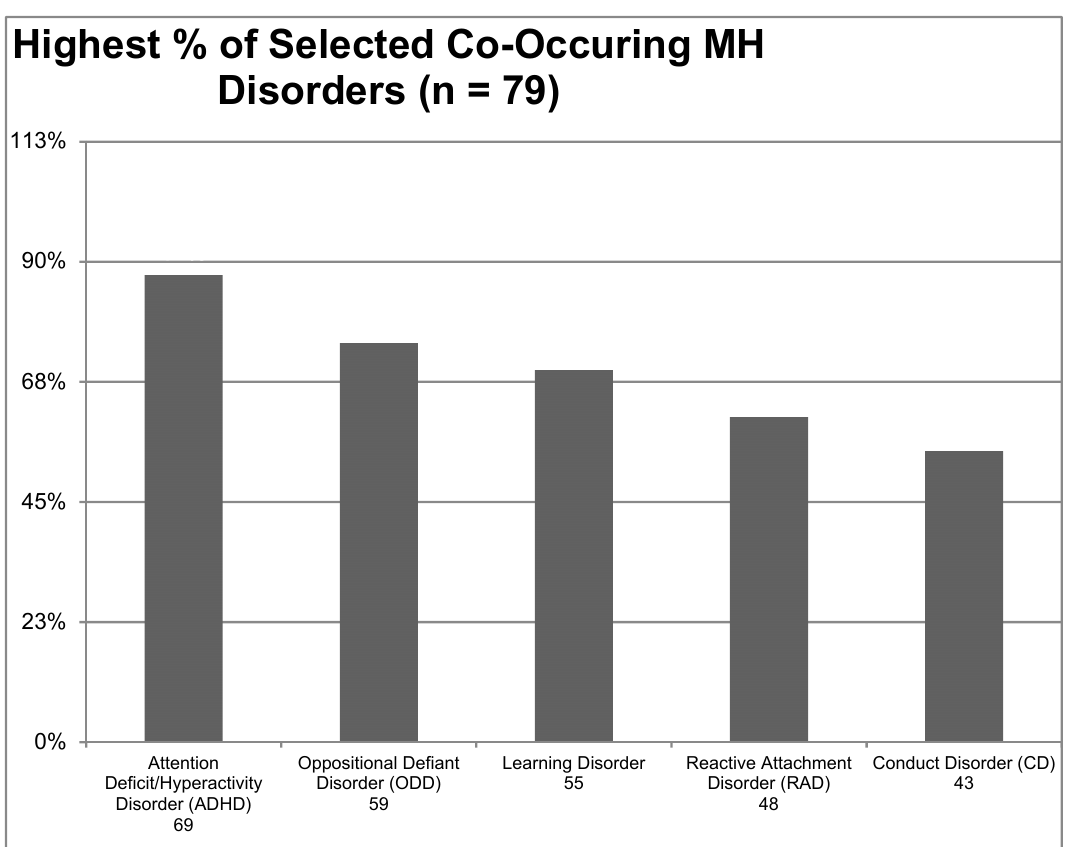
Figure 2. Highest % of selected co-occurring mental health disorders.